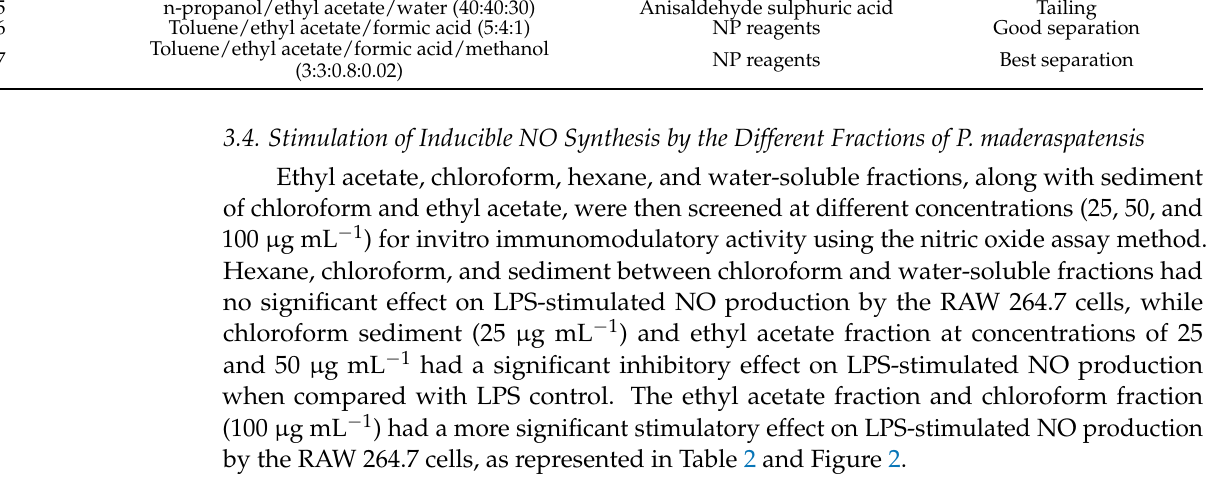
Table 2. Effect of P. maderaspatensis fractions on NO production in LPS-stimulated RAW 264.7cells.